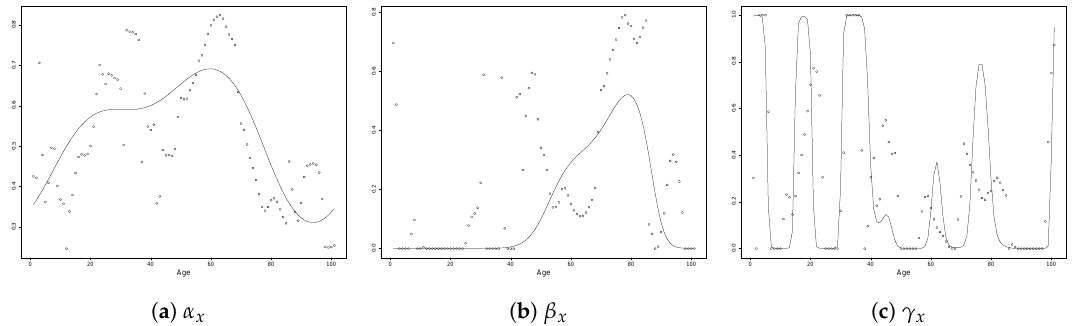
Figure 1. Estimated α x , β x and γ x for Australian female mortality data.